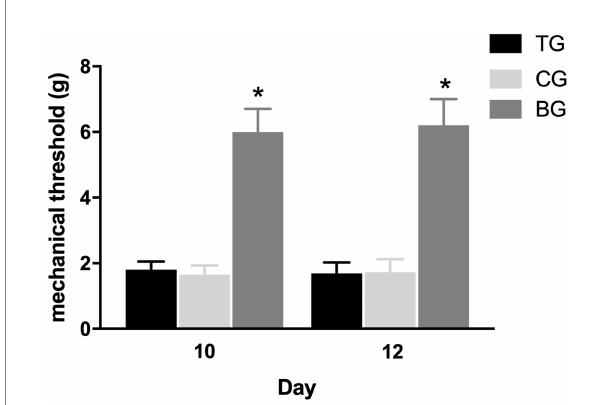
FIGURE 5 Defibrinogenation had no effect on the mechanical hyperalgesia. The mechanical withdrawal threshold in TG following each batroxobin administration on day 10 and 12 did not differ significantly from CG. * p < 0.05.